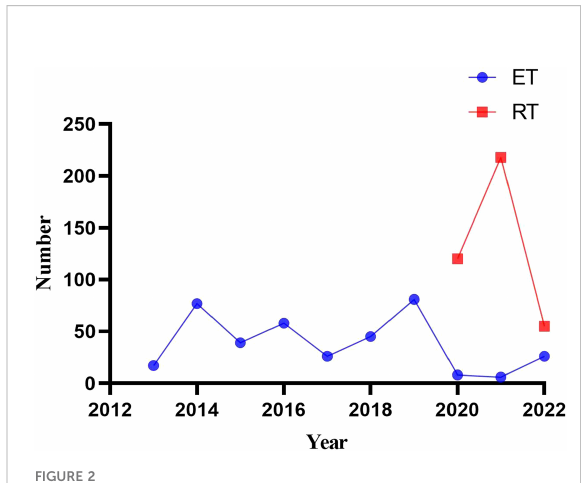
FIGURE 2 The changing trend of robotic and endoscopic thyroidectomy in our center from 2013 to 2022.